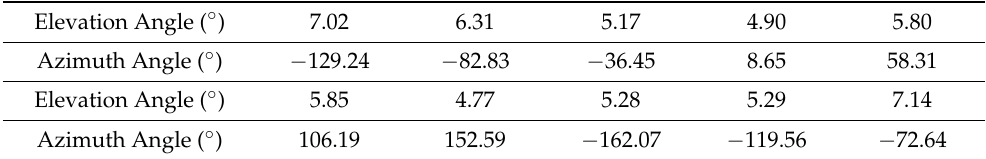
Table 7. DOA estimation by CPCMA-ESPRIT for inner race fault signal at 290 rpm.